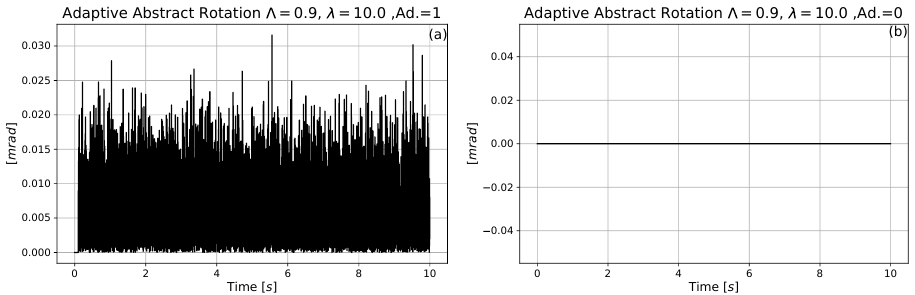
Figure 23. The adaptively deformed 2nd time-derivatives. ( a ): Adaptive. ( b ): Non-adaptive.